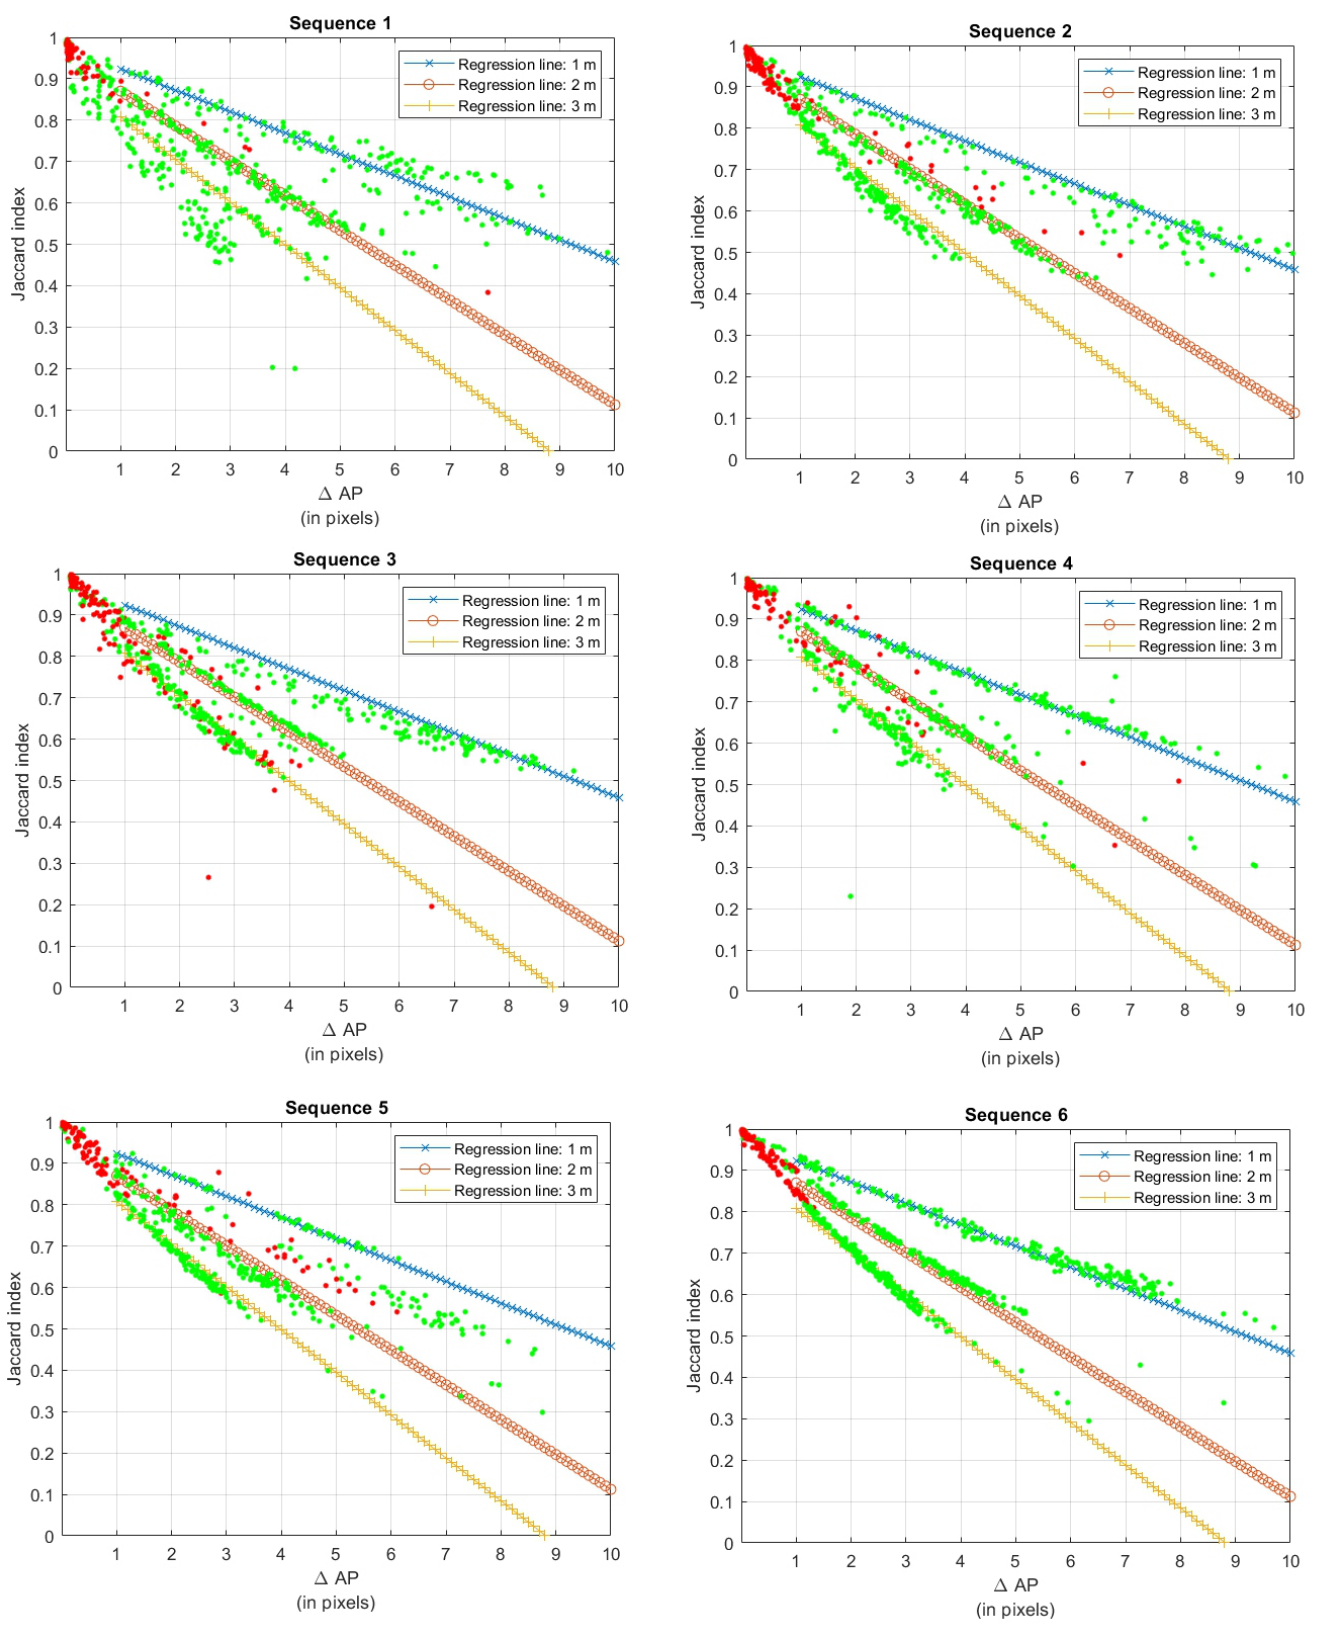
Figure 11. Results—test set—sequences 1–6 from Figure